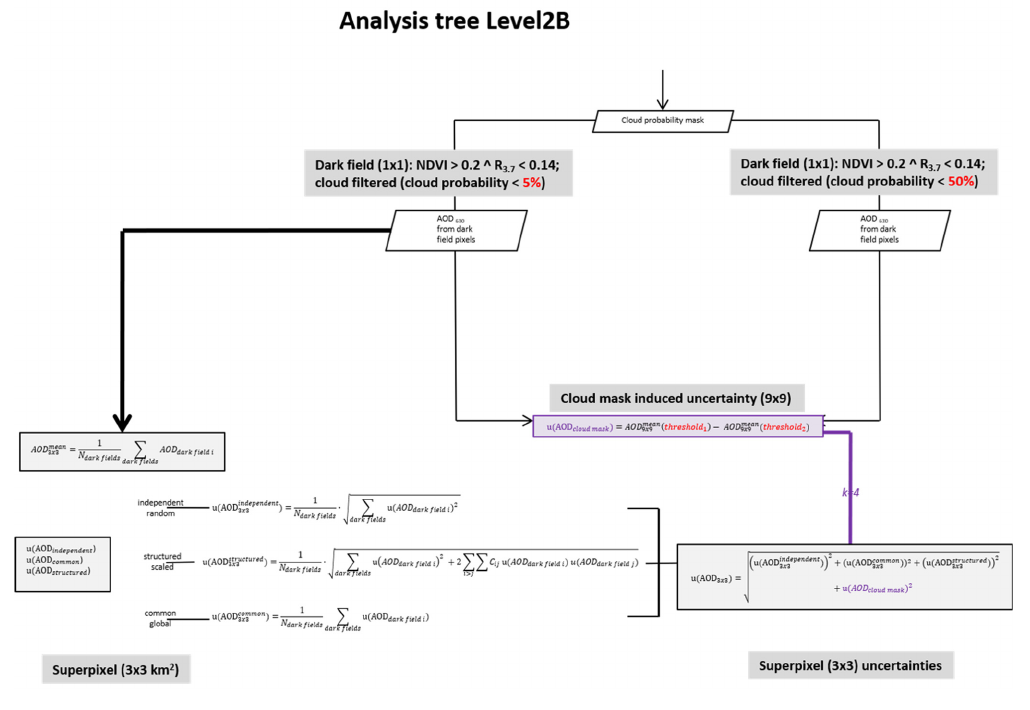
Figure 3. L2B analysis tree for AVHRR AOD.